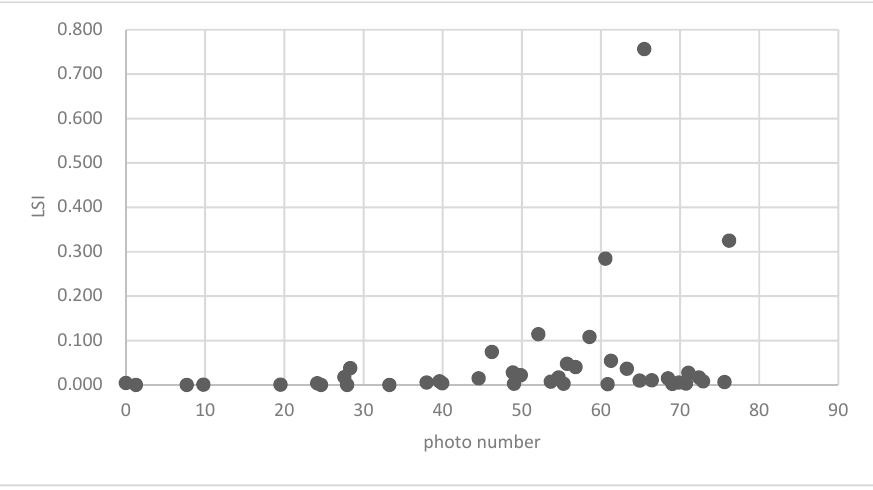
Figure 38. Association between brush LSI and photo number.